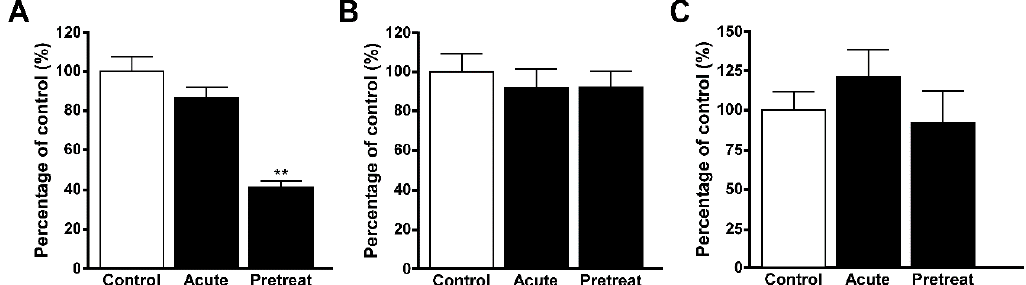
Figure 3. Effect of lysosomal pH on quinacrine and EFV uptake in lysosome-enriched fractions. ( A ) The uptake of quinacrine (5 μ M) in the fraction of TR-iBRB2 cells was examined in the presence or absence of 100 nM bafilomycin A1 at 37 °C for 30 min. ( B ) The uptake of EFV (1 μ M) in the fraction of TR-iBRB2 cells was examined in the presence or absence of 100 nM bafilomycin A1 at 37 °C for 30 min. ( C ) The uptake of EFV (1 μ M) in the fraction of RPE-J cells was examined in the presence or absence of 100 nM bafilomycin A1 at 37 °C for 30 min. Bafilomycin A1 is an inhibitor of V-ATPase that attenuate the lysosomal acidic interior pH, and the uptake was examined in the presence or absence of 100 nM bafilomycin A1 at 37 °C for 30 min. In a pretreat condition, fractions were treated with 100 nM bafilomycin A1, and the uptake was performed in the absence of bafilomycin A1. In an acute condition, fractions were treated with ICF-buffer, and the uptake was performed in the presence of 100 nM bafilomycin A1. Each column represents the mean ± S.E.M ( n = 4). ** p < 0.01, significantly different from the control.